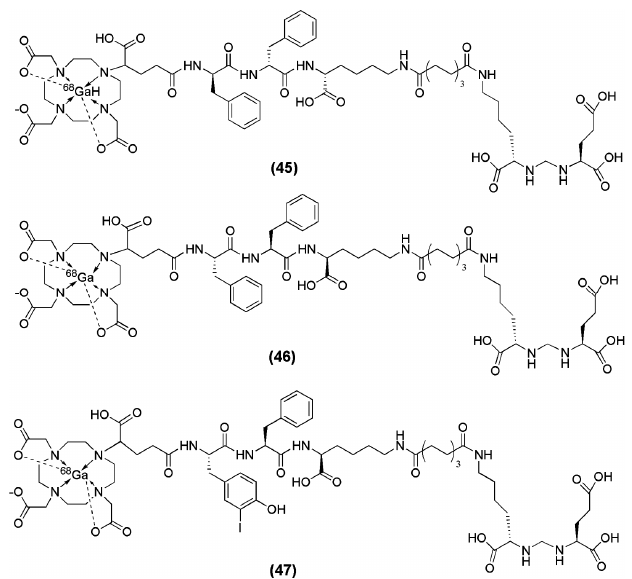
Figure 14. Chemical structures of the three generations (DOTAGA-FFK(Sub-KuE) ( 45 ), DOTAGA-ffk (Sub-KuE) ( 46 ) and of DOTAGA-(I-y)fk(Sub-KuE) ( 47 )) PSMA inhibitors labeled with 68 Ga [134,135].